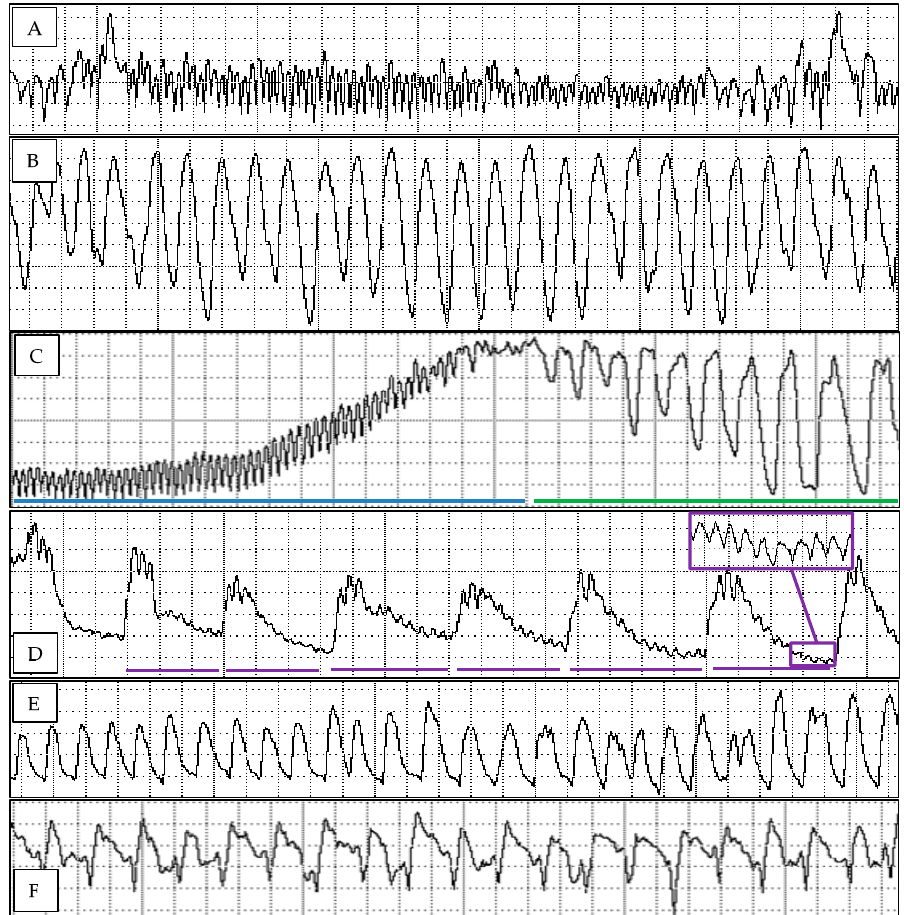
Figure 1. Waveform excerpts of Diaphorina citri probing four Cleopatra Mandarin selections and Pummelo. ( A ) Waveform C representing probing epidermis, parenchyma, and cambium tissues en route to vascular tissues. 0.27 s/div. ( B ) Waveform G representing ingestion from xylem tissues. 0.13 s/div, peak frequency 0.15 s. ( C ) The first portion of waveform D showing the voltage rise (blue line) from waveform C and the tall, narrow peaks (green line) that immediately follow waveform C. 0.27 s/div. ( D ) The later portion of waveform D showing the lower voltage, and lower frequency peaks (each with a purple line underneath, peak frequency 2.67 s) with smaller, higher frequency peaks superimposed. These smaller, high frequency peaks (purple inset box) will grow into higher voltage peaks that will become the first peaks of waveform E1. 0.27 s/div. ( E ) Waveform E1 representing salivation in phloem tissues. 0.13 s/div, peak frequency 0.133 s. ( F ) Waveform E2 representing ingestion from phloem tissues. 0.13 s/div, peak frequency 0.19 s.